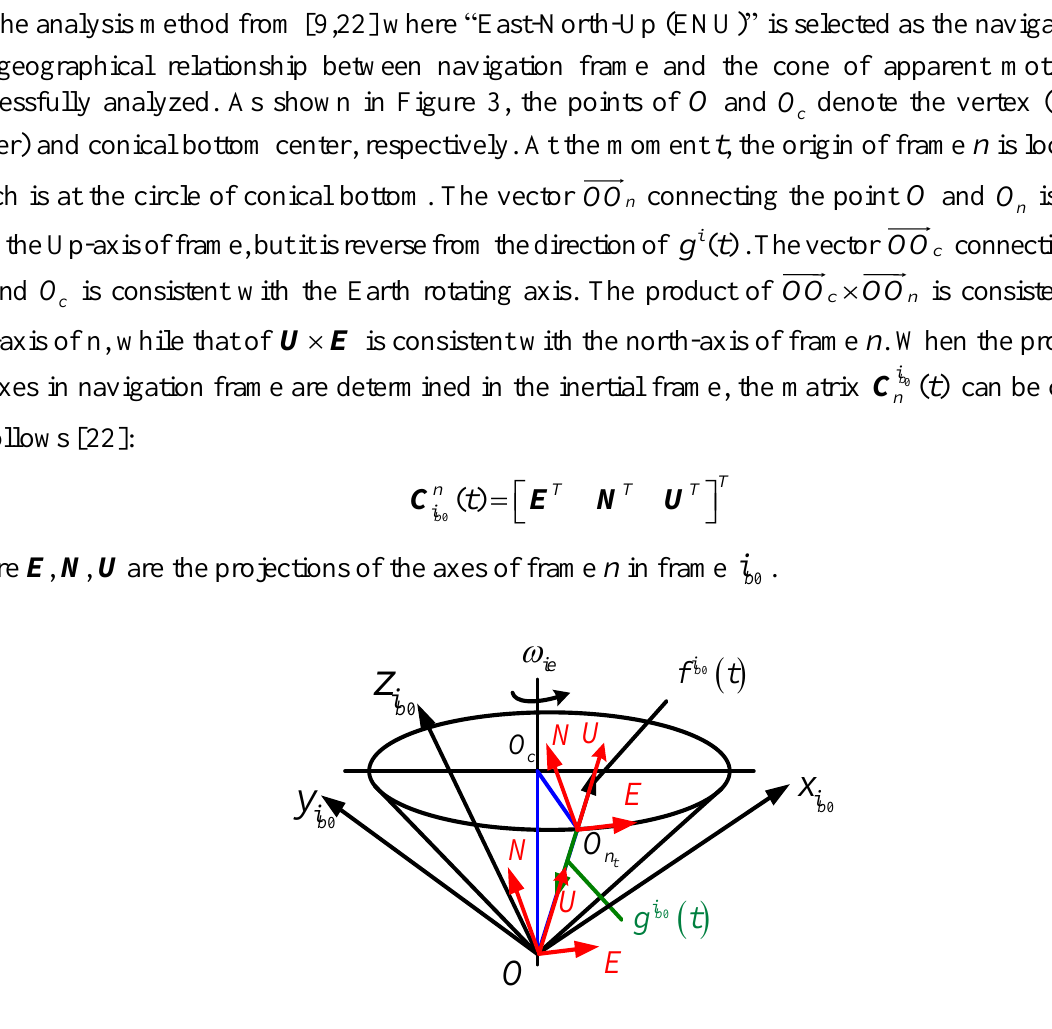
Figure 3. Alignment mechanism based on gravitational apparent